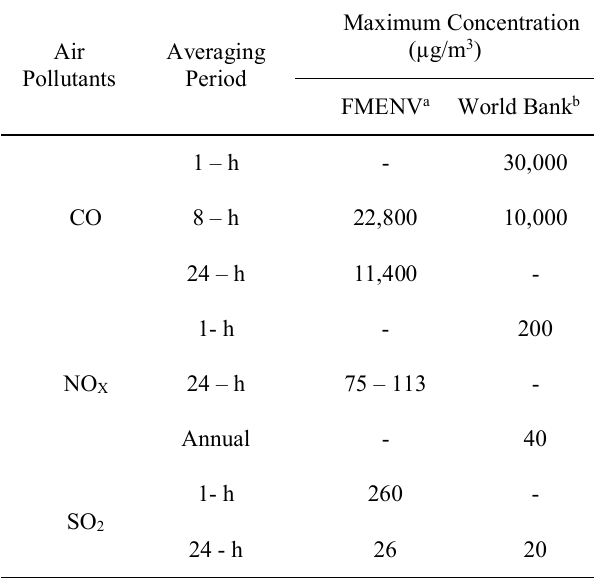
Figure 1. Sokoto Aiyekale Dump Site in Ilorin.